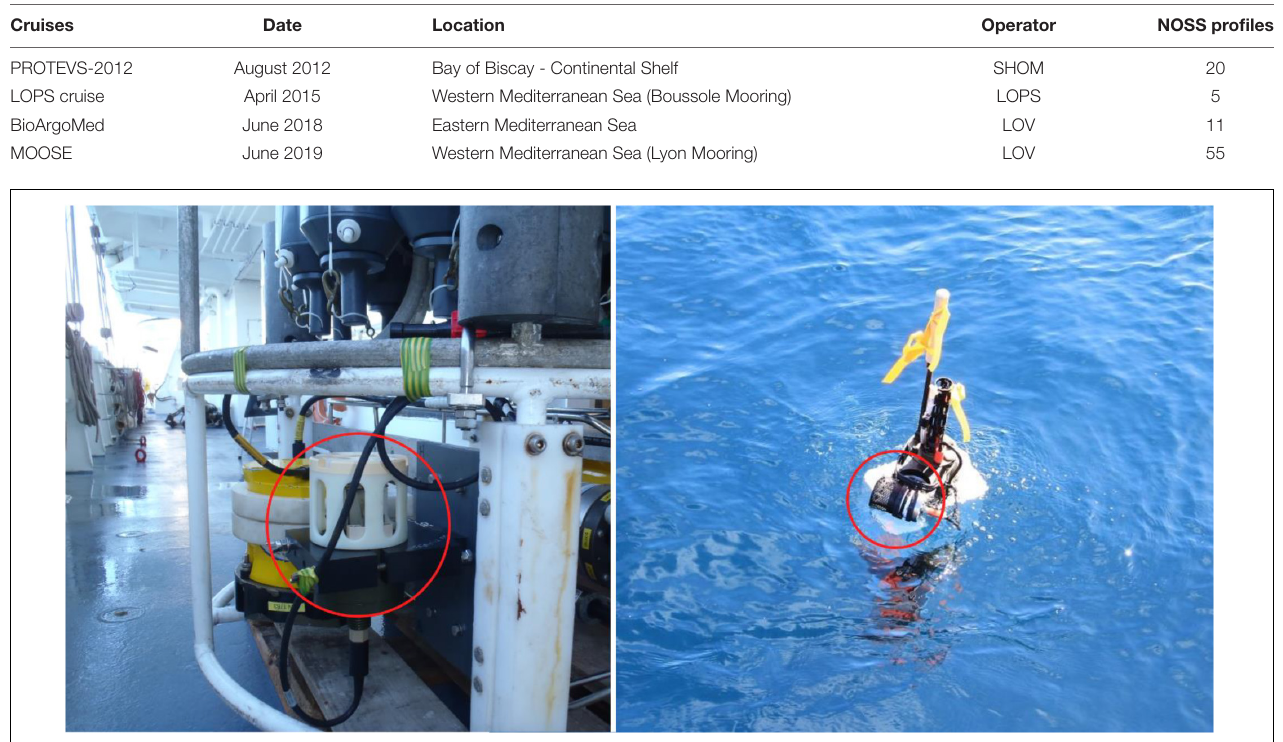
TABLE 1 | List of NOSS deployments and tests at sea.